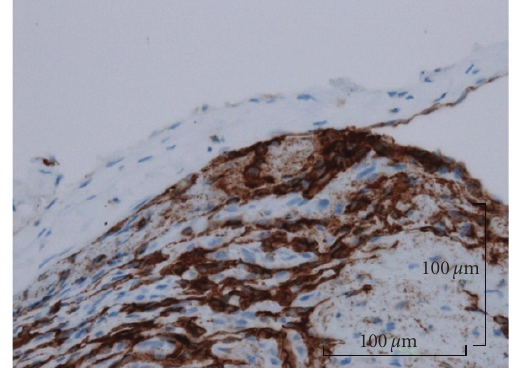
Figure 6: The endothelial cells of this lesion were reactive on immunohistochemical staining for alpha-SMA, and alpha-SMA was positive in the single layer of the blood vessel walls (yellow arrows). Thin, expanded smooth muscle cells in the vessel wall (white arrows) were also observed (Original magnification, × 16; Bar, 100